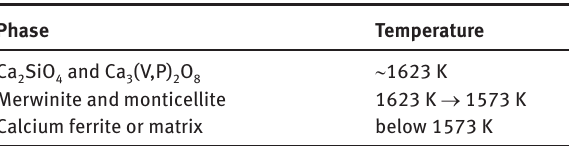
Table 4: Crystallization temperature of mineral phase Phase